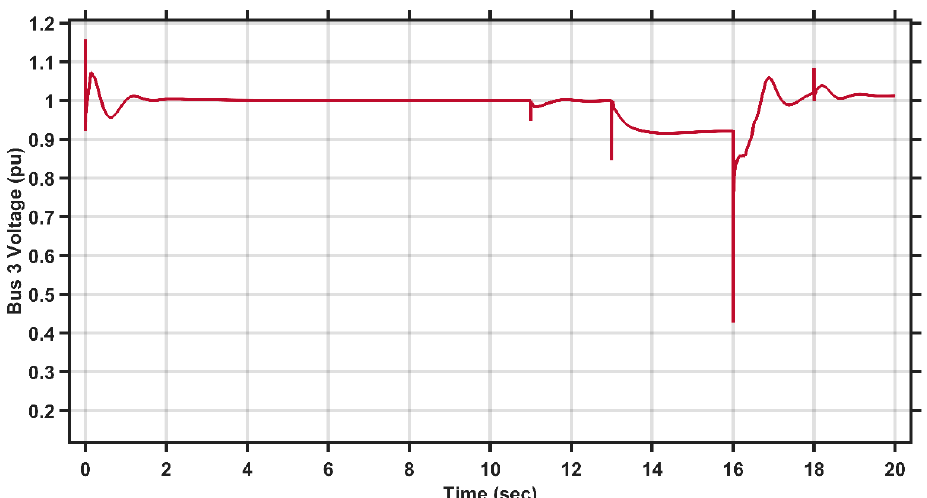
Figure 27. Bus 3 voltage at islanded operation for the IEEE 9-bus system.